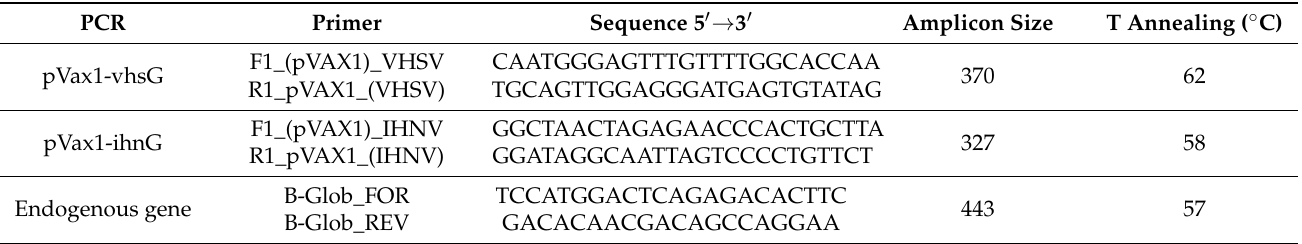
Table 3. PCR conditions and primers for plasmid and endogenous gene